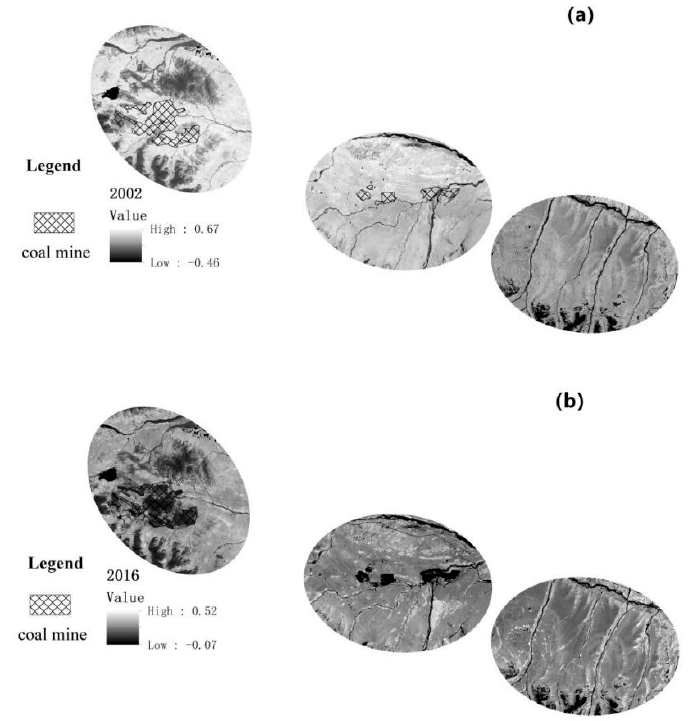
Figure 2. NDVI index around coal mines in 2002 ( a ) and 2016 ( b ). In ( a ) and ( b ), the left and middle maps are the NDVI distribution of the mining-affected area, while the rightmost map is the contrast test area.